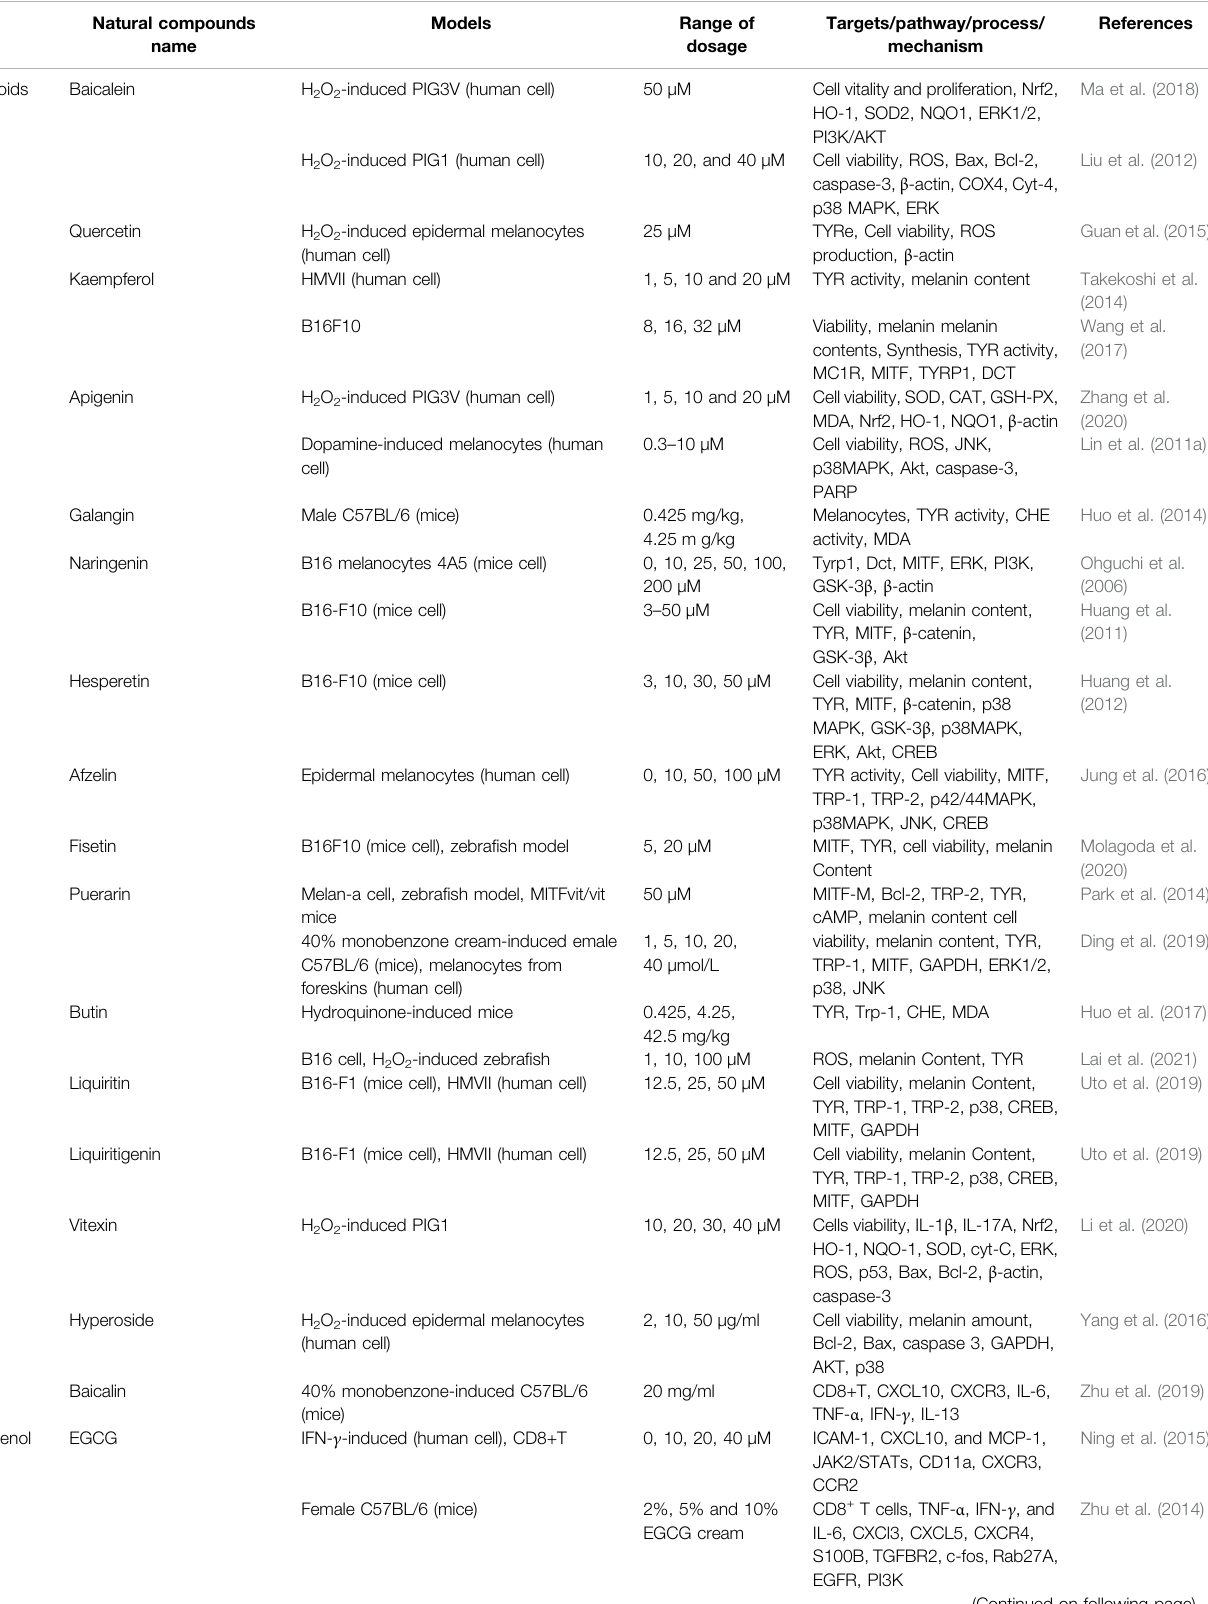
TABLE 1 | Summary of natural products for the treatment of vitiligo in